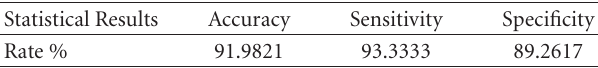
Table 1: Performance of pelvic bone fracture